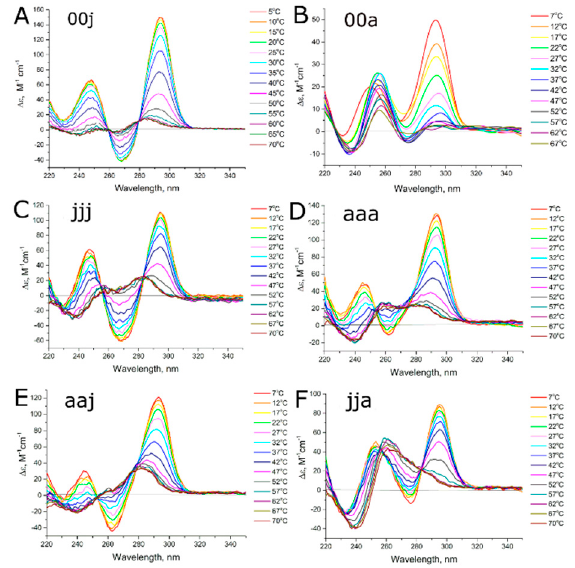
Figure 3. CD spectra of the thermal melting of aptamers ( A ) HD1 (00j), ( B ) NU (00a), ( C ) 31-TBA (jjj), ( D ) NU172 (aaa), as well as hybrid aptamers ( E ) aaj and ( F ) jja.